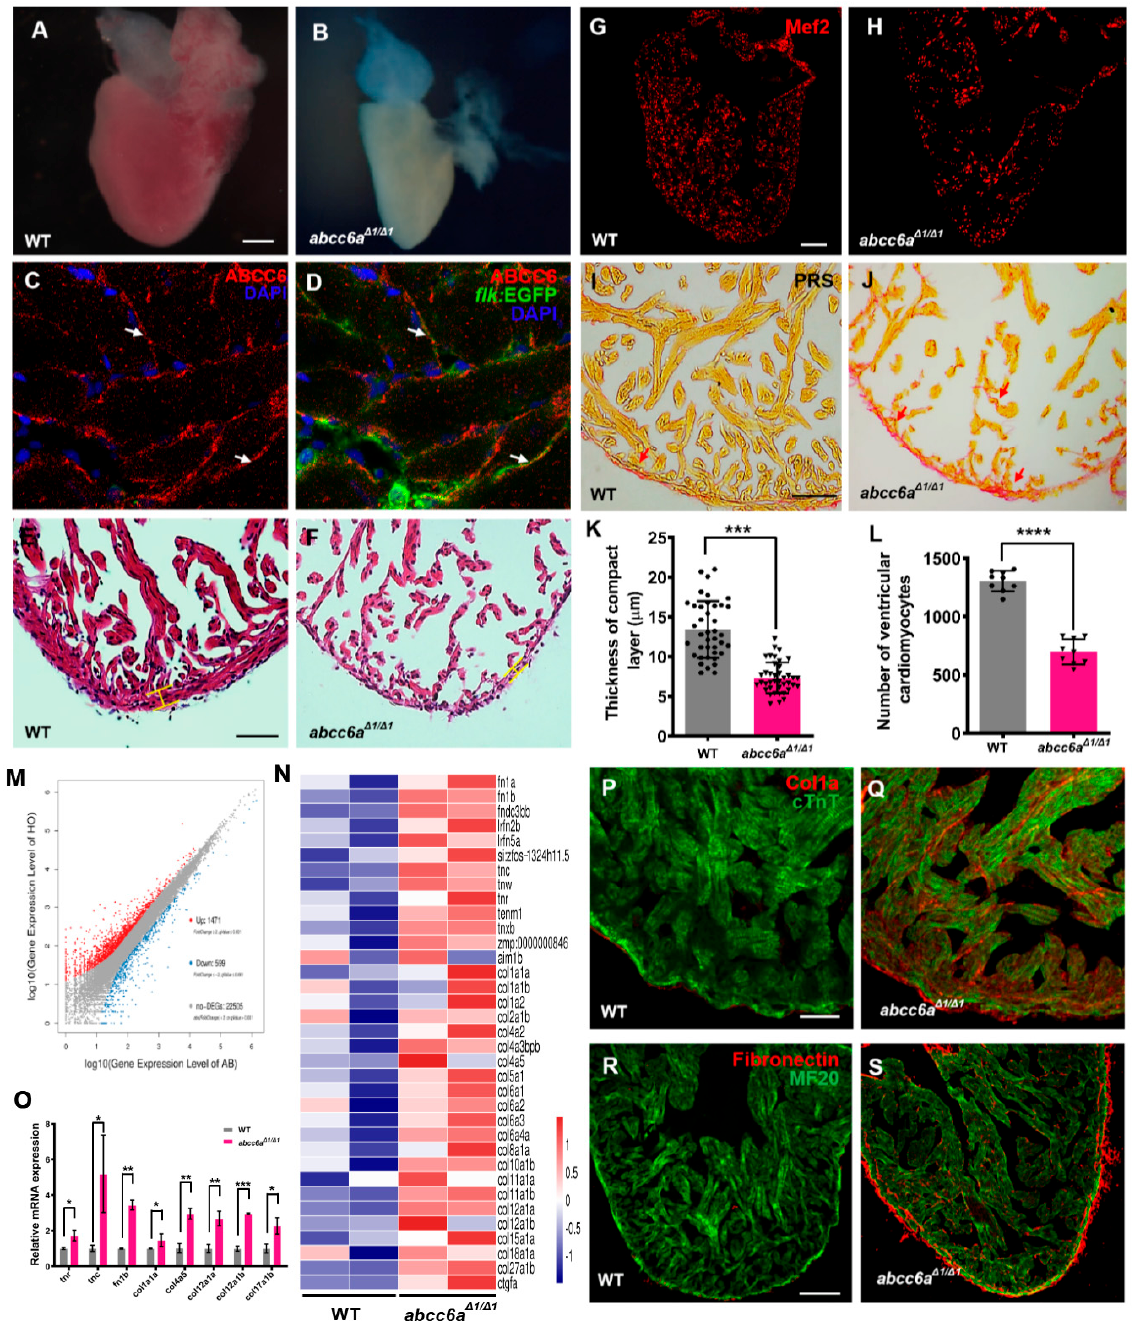
Figure 3. abcc6a ∆ 1/ ∆ 1 mutation upregulates extracellular matrix genes and leads to fibrotic adult hearts. ( A , B ) Whole- mounted photographs of adult heart at 8 mpf showing cardiac shrinkage and fibrosis phenotypes in abcc6a ∆ 1/ ∆ 1 ( B ), compared with WT sibling heart ( A ). ( C , D ) Abcc6 protein (red) recognized with anti-Abcc6 antibody overlaps with endocardial cells marked by flk :EGFP (green) in adult Tg(flk:EGFP) heart. Arrows in ( C , D ) point to endocardial cells expressing Abcc6. ( E , F ) Hematoxylin-eosin (HE) staining exhibits thinner compact layer and fewer myocardial cells in abcc6a ∆ 1/ ∆ 1 heart ( F ), compared to WT sibling hearts ( E ). ( G , H ) Representative Picrosirius Red staining of heart sections (yellow for cardiomyocyte fiber, red for collagen) shows superfluous collagen and elastin deposition residing in a compact layer and trabeculae in abcc6a ∆ 1/ ∆ 1 adult hearts ( H ), compared to WT hearts ( G ). ( I , J ) Immunofluorescent section images of abcc6a ∆ 1/ ∆ 1 mutant hearts (J) and WT siblings (I), stained with anti-Mef2 antibody. ( K ) Quantitative analysis shows a thinner compact layer thickness in abcc6a ∆ 1/ ∆ 1 adult heart (n = 10, 4 measuring points per sample), compared with WT sibling heart (n = 10, 4 measuring points per sample). *** p < 0.001, Student’s t -test (unpaired, two-tailed). ( L ) Quantification of the